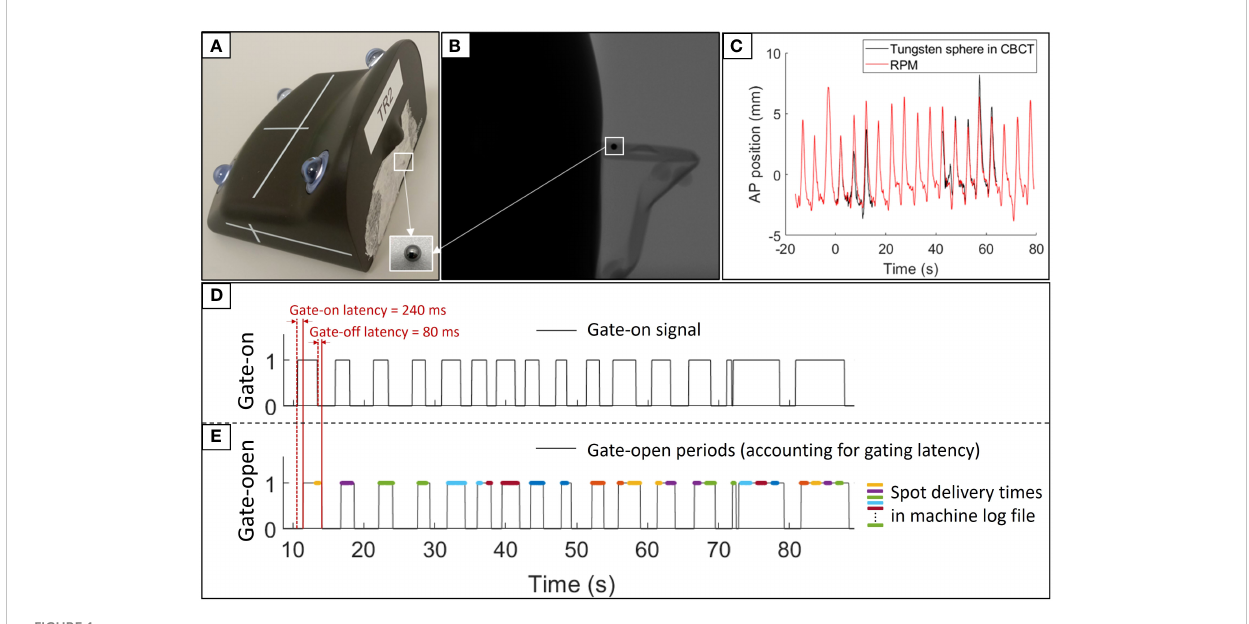
FIGURE 1 Synchronization of RPM log fi les. (A) Marker block with the tungsten sphere used for synchronization with the CBCT projections. (B) A CBCT projection showing the marker block and tungsten sphere. (C) Synchronized RPM signal (red) and anterior-posterior (AP) tungsten sphere trajectory extracted from the CBCT projections (black). (D) Gate-on signal in RPM log fi le used for synchronization with spot delivery times. (E) Gate-open times accounting for the gating latency (black) and synchronized spot delivery times from machine log fi les (colored lines, with different colors indicating different energy